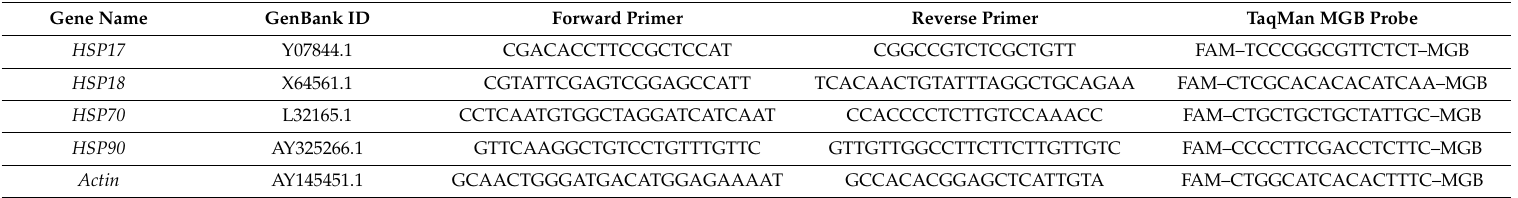
Table 1. Sequence origins and primer and probe sequences used in the study.